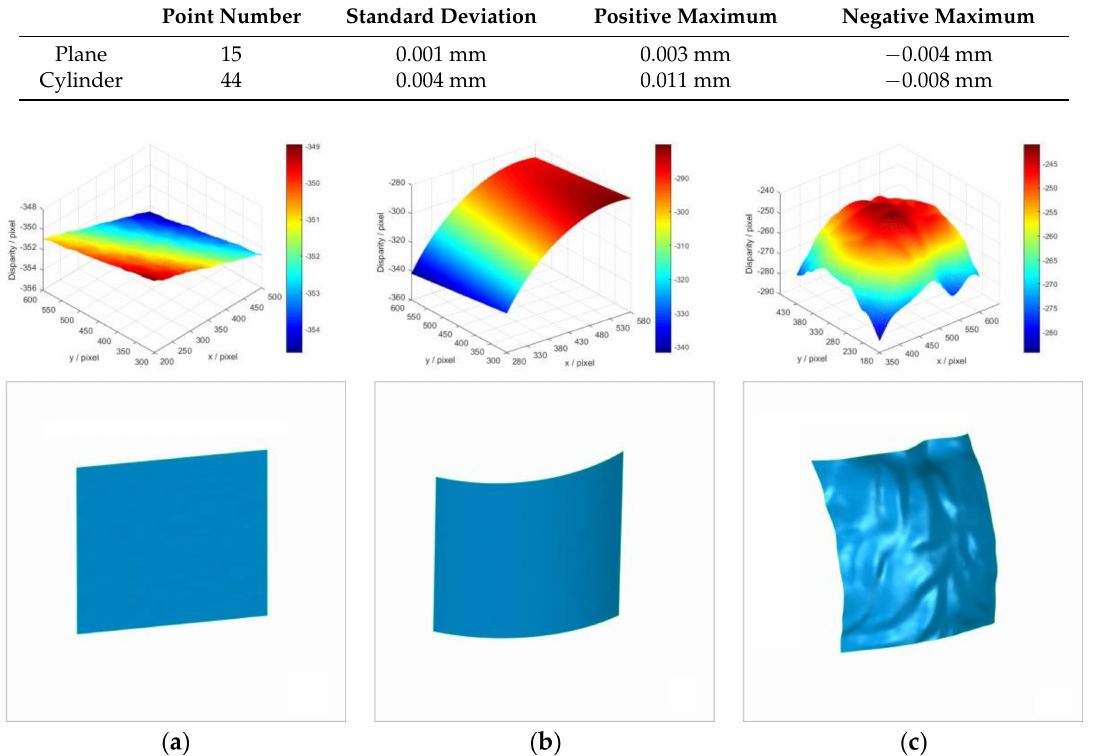
Figure 7. Rectified stereo image pairs for real tests, the left images are listed on the up row and the corresponding right images are listed in the bottom row: ( a ) Plane surface; ( b ) Cylinder surface; and ( c ) Back surface of a plaster head. Table 3. Plane and cylinder surface fitting results of 3D coordinates measured by CMM.